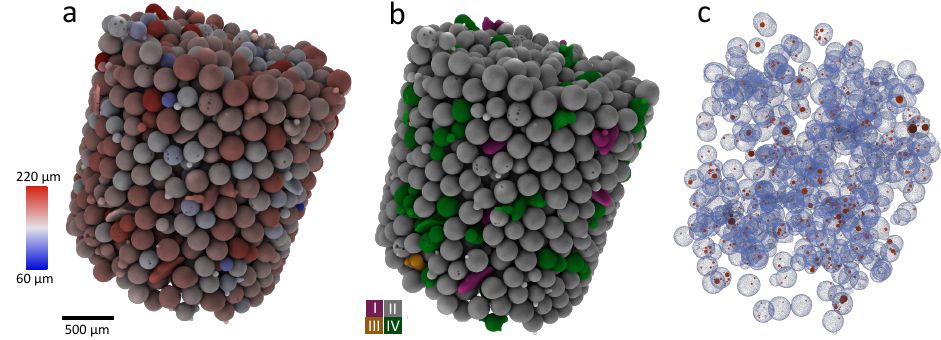
Figure 2. Micrometre-size glass bead quantification with X-ray CT. ( a ) Glass beads coloured according to equivalent diameter from blue (60 µ m) to red (220 µ m). ( b ) The same glass beads coloured according to Zingg’s [66] shape classification (discs (I): purple, spheres (II) grey, blades (III): orange, rods (IV): green). ( c ) Only beads with internal pores shown (beads in blue, pores in